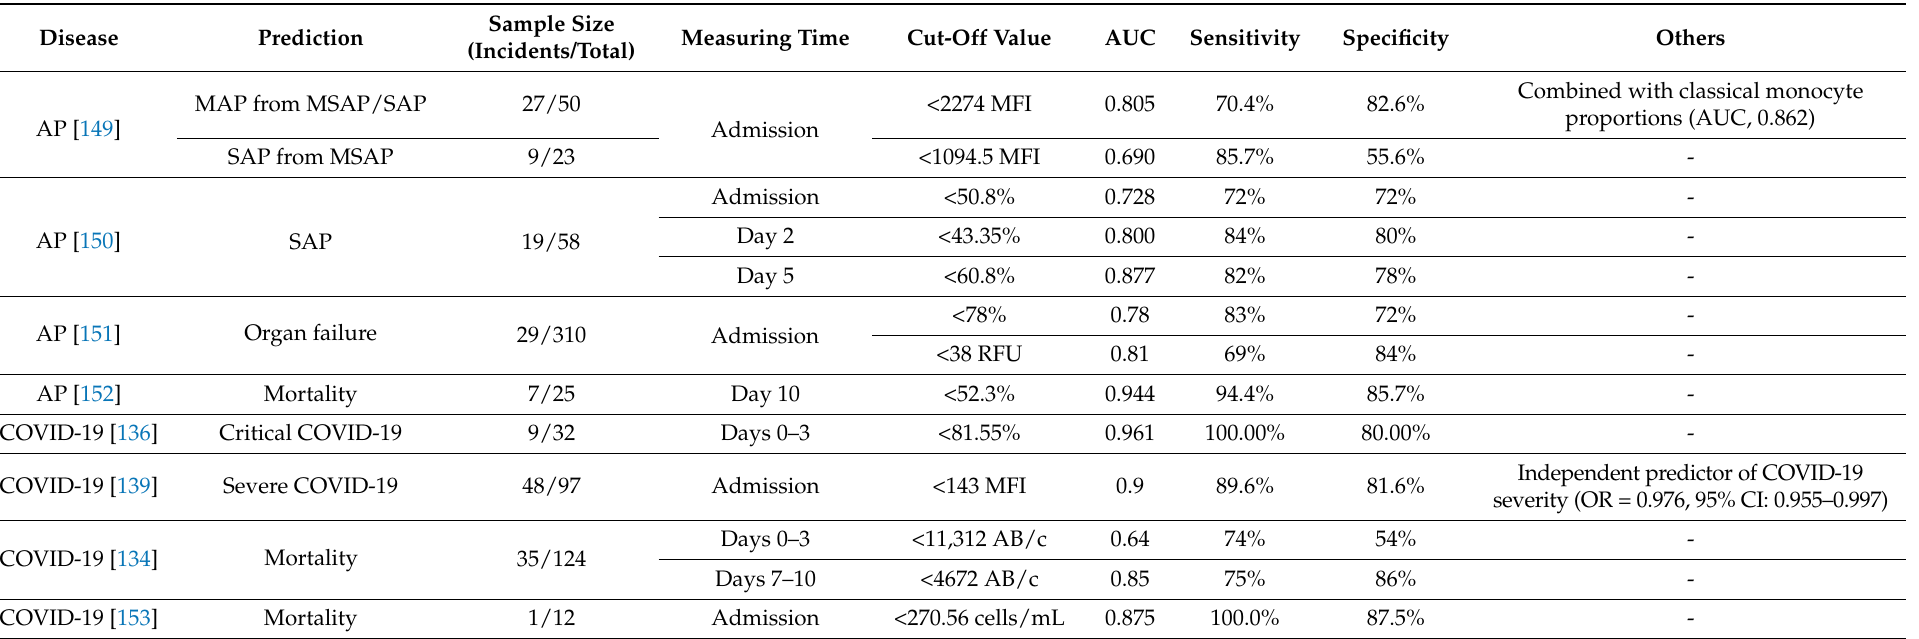
Table 2. Predictive Values of mHLA-DR for severity and mortality in AP and